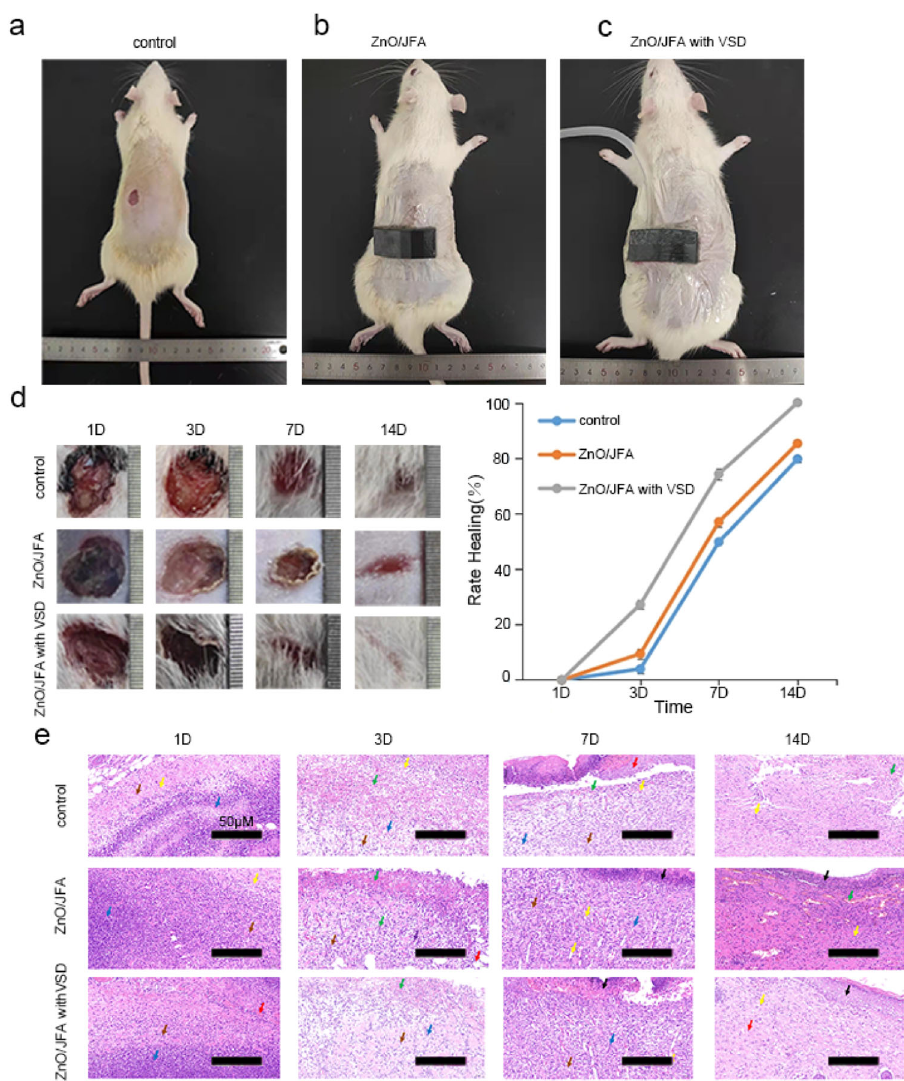
Fig. 6 Therapeutic effect evaluation of JFA, ZnO/JFA, and ZnO/JFA with VSD using a mouse skin model. Mouse skin was treated with povidone- iodine (PVP-I) as a blank control and a blank control; b ZnO/JFA and c ZnO/JFA with VSD. d Representative image of the purulent infected wound and quantitative analysis of the healing rate. e Histopathological analysis after 1 D, 3 D, 7 D, and 14